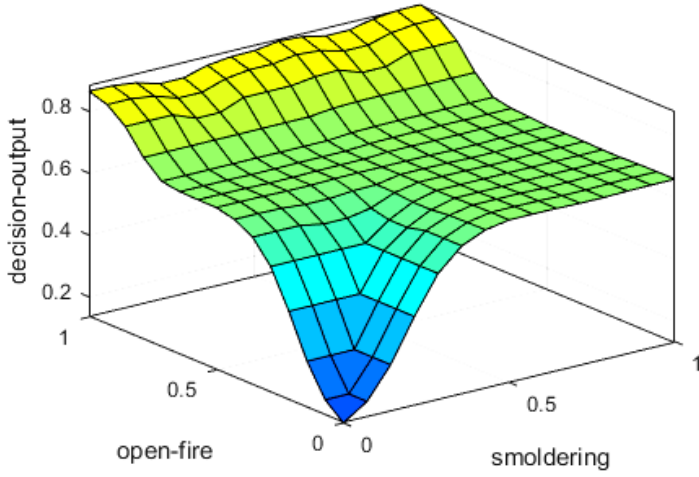
Figure 2. Fuzzy inference output surface.